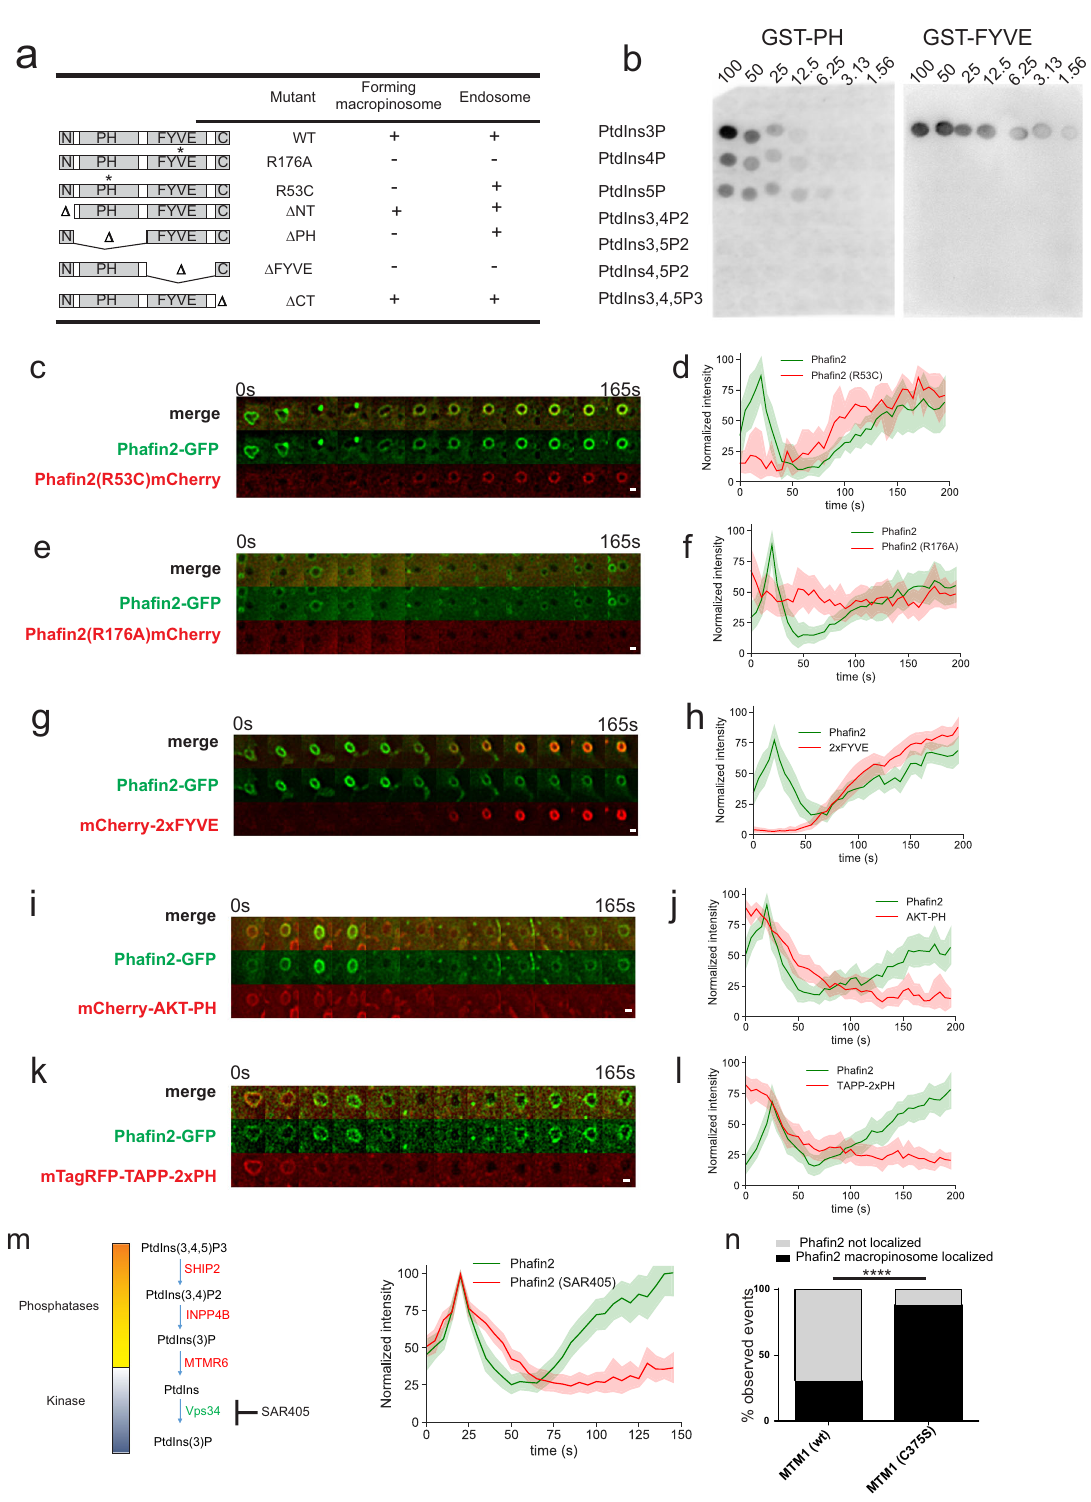
Pha fi n2 is a phosphoinositide coincidence sensor . While our experiments suggested that PtdIns3P is required Pha fi n2 locali- zation, they did not address how the PH domain contributes to Pha fi n2 localization. An isolated PH domain was cytosolic (Fig. 4a), suggesting insuf fi cient af fi nity to membranes. We gen- erated a tandem construct of the Pha fi n2 PH domain (2xPH), which did localize to newly formed macropinosomes, but, sur- prisingly, not to early macropinosomes positive for wild-type